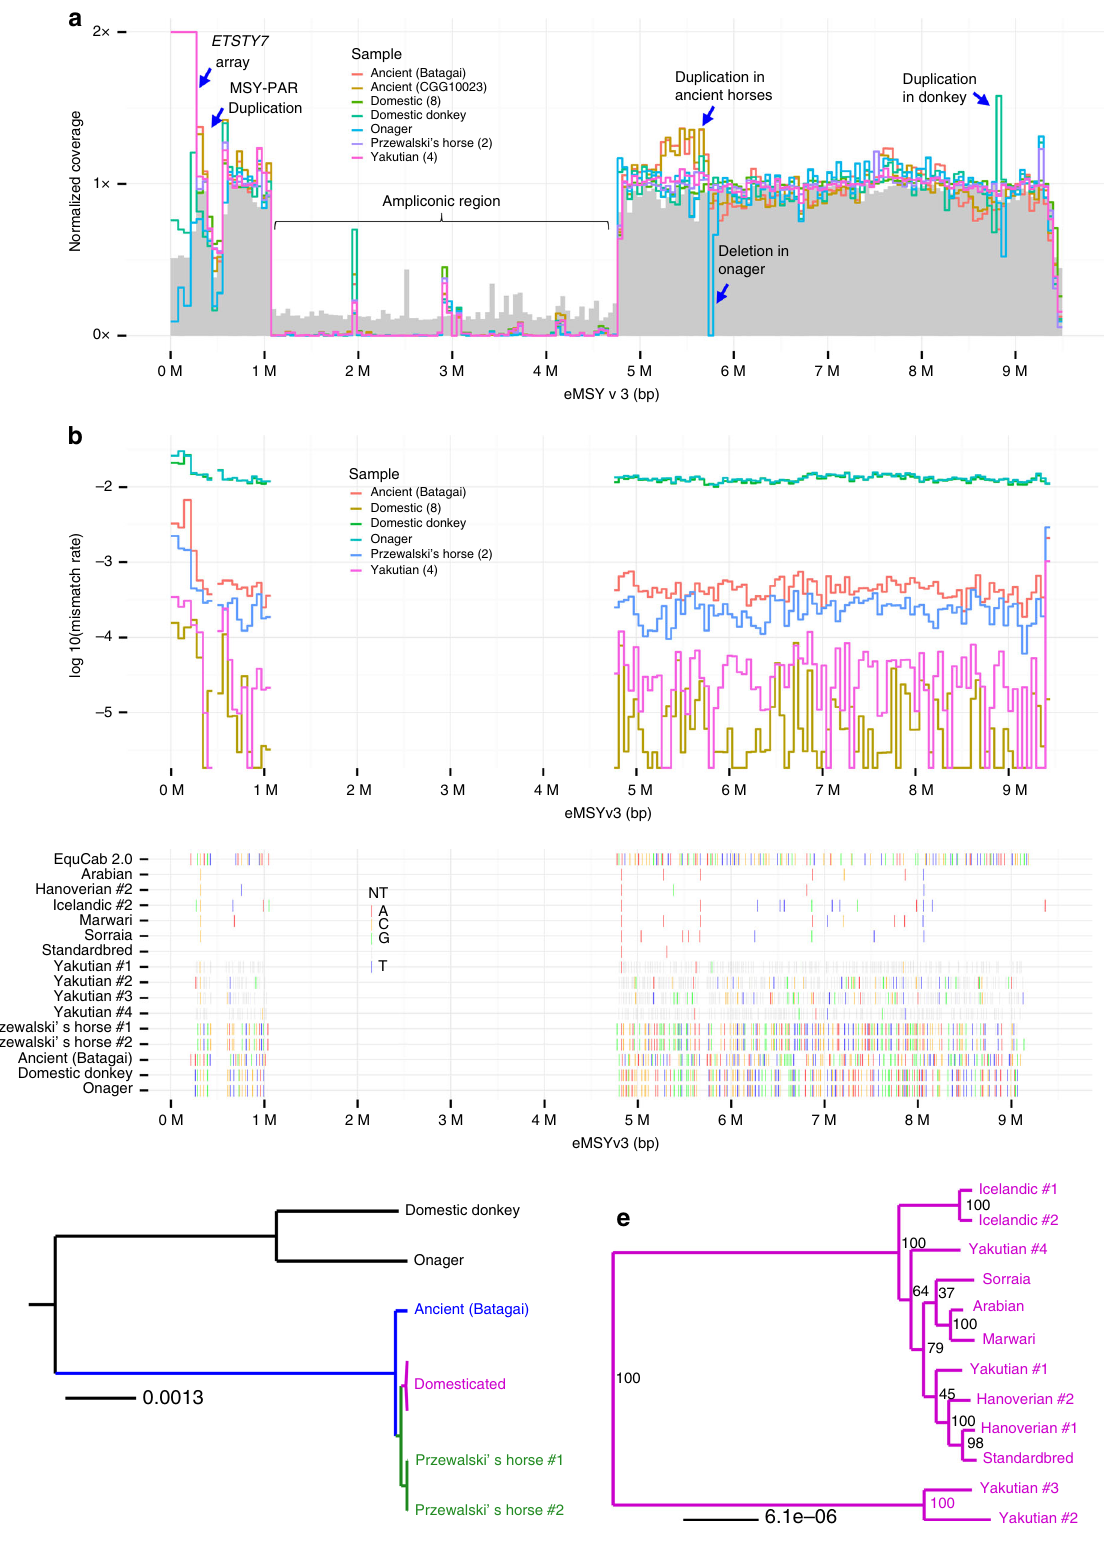
Fig. 7 Comparison of equid MSY. a Normalized coverage for each group of samples in 1 kbp blocks. Mappability (between 0 and 1) is shown in gray. b Average mismatch rates (relative to reference sequence) in 1 kbp blocks. c Variable sites in eMSY. Only sites called in the eMSY sequence and covered in at least one individual in each group are shown. EquCab 2.0 shows the nucleotide observed on eMSY, while rows for individuals show the SNP observed at that site for an individual, or nothing if the reference nucleotide is observed. Gray indicates sites not called in that individual. d and e Maximum likelihood phylogenies generated from supermatrix of high-mappability genomic blocks for equids and horse breeds,